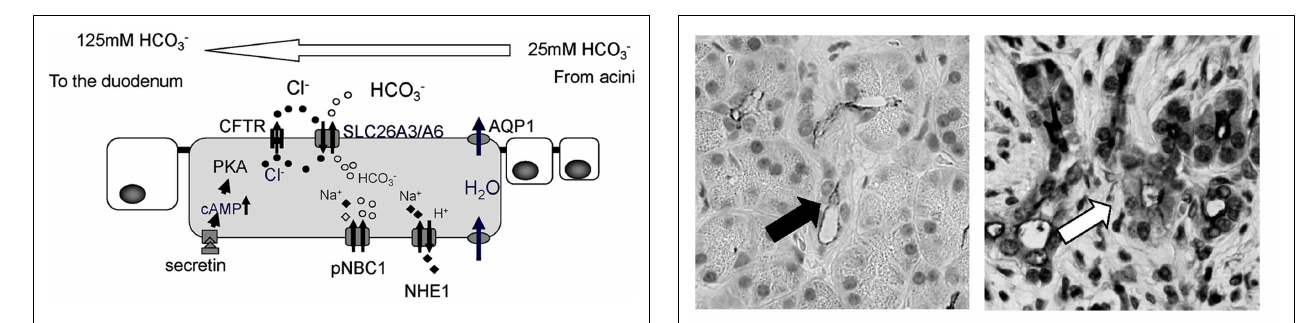
FIGURE 2 | Cellular mechanism proposed for ion and fluid secretion by the pancreatic duct epithelium. The primary fluid secreted by acinar cells contains a large amount of digestive enzymes and 24mM HCO − . FIGURE 3 | Immnolocalization of CFTR in the pancreas of normal and 3 Intracellular HCO − leaves the cell in exchange for Cl − , mediated by SLC26 chronic pancreatitis. In the normal subjects, the CFTR chloride channel is 3 anion exchangers. Cl − is supplied to the lumen by a secretin-stimulated Cl − exclusively localized in the apical plasma membrane of small pancreatic channel, the Cystic fibrosis transmembrane conductance regulator (CFTR). ducts (left panel). In contrast, the CFTR chloride channel is largely retained For fluid movement across the epithelium, aquaporin (AQP) water channels at the cytoplasm of pancreatic ducts and is not transported to the proper are present at both the apical and basolateral membranes of smaller ducts apical plasma membrane domain in alcoholic chronic pancreatitis (right in the rat (Furuya et al., 2002) and human pancreas (Burghardt et al., 2003). panel; modified from Freedman, 1998). PKA, protein kinase A; pNBC1, pancreatic sodium bicarbonate cotransporter1; NHE1, sodium proton exchanger1.